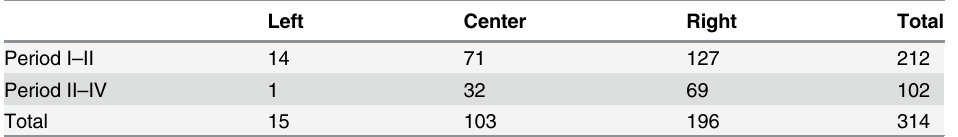
Table 4. Contingency table of the number of newly settled gemmae at different positions within the study site during periods I – II and II – IV. Left Center Right Total Period I – II 14 71 127 212 Period II – IV 1 32 69 102 Total 15 103 196 314 The surveyed site was divided into left, center and right regions. Period I – II is the increasing period, and period II – IV is the decreasing period. Dates I – IV are de fi ned in the